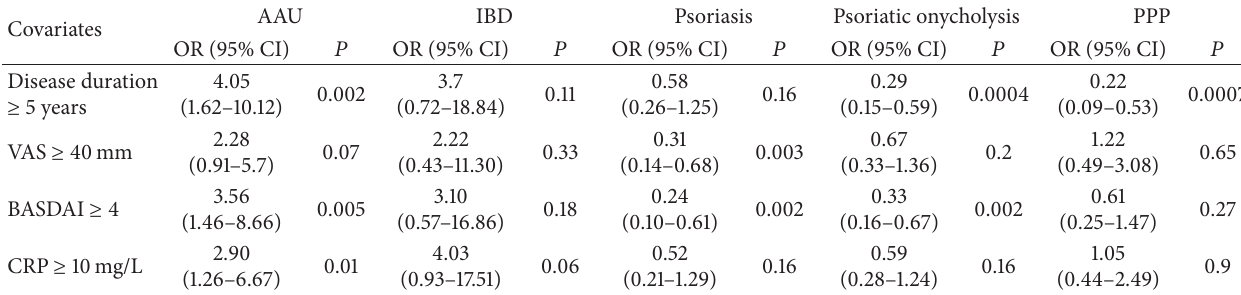
Table 4: A logistic regression model of the OR of selected markers of disease activity in spondyloarthritis groups of patients with different extra-articular symptoms compared to controls.